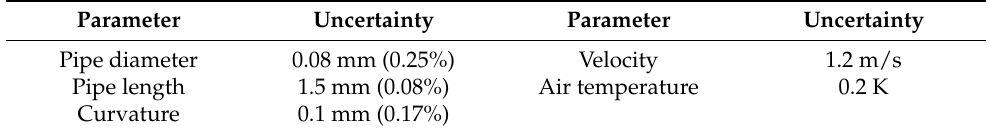
Table 1. Major parameter uncertainties [18].